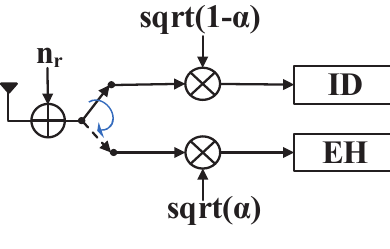
Figure 3. The TS